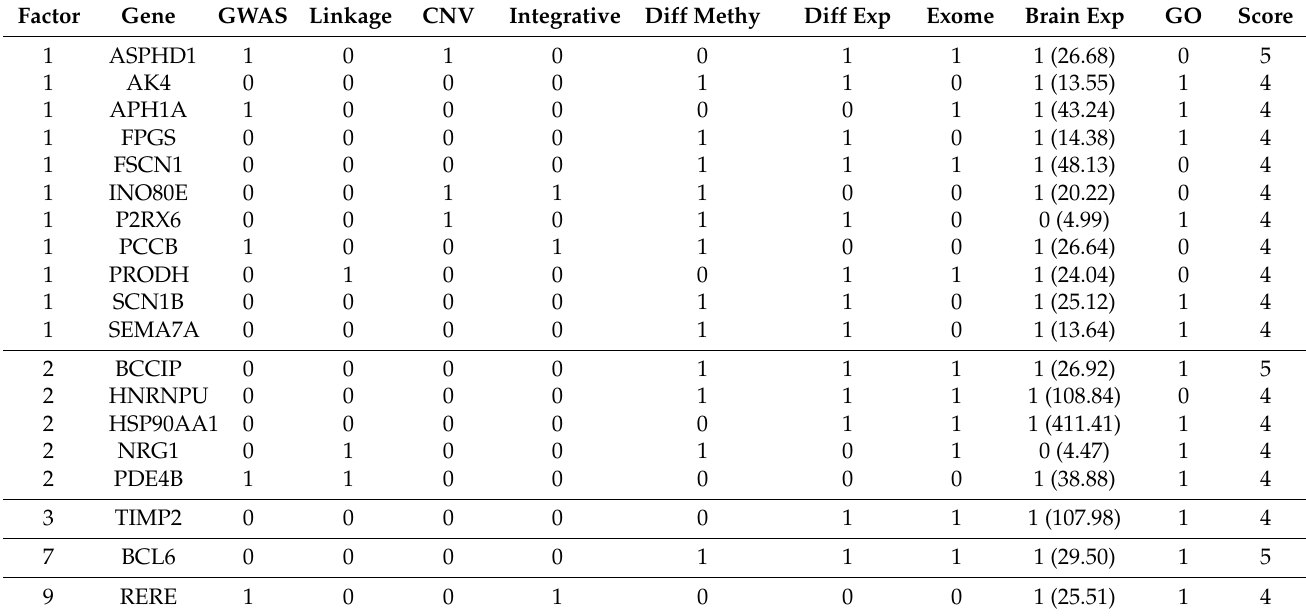
Table 1. Genes in gene factors with high supportive evidences, including genome-wide association study (GWAS), Genome Wide Linkage Study (Linkage) Copy Number Variation (CNV), integrative analysis (Integrative), differentially methylated (Diff Methy), Differentially expressed (Diff Exp), identified by exome sequencing (Exome), expression level in brain tissues (Brain Exp), Gene Ontology (GO), and total score